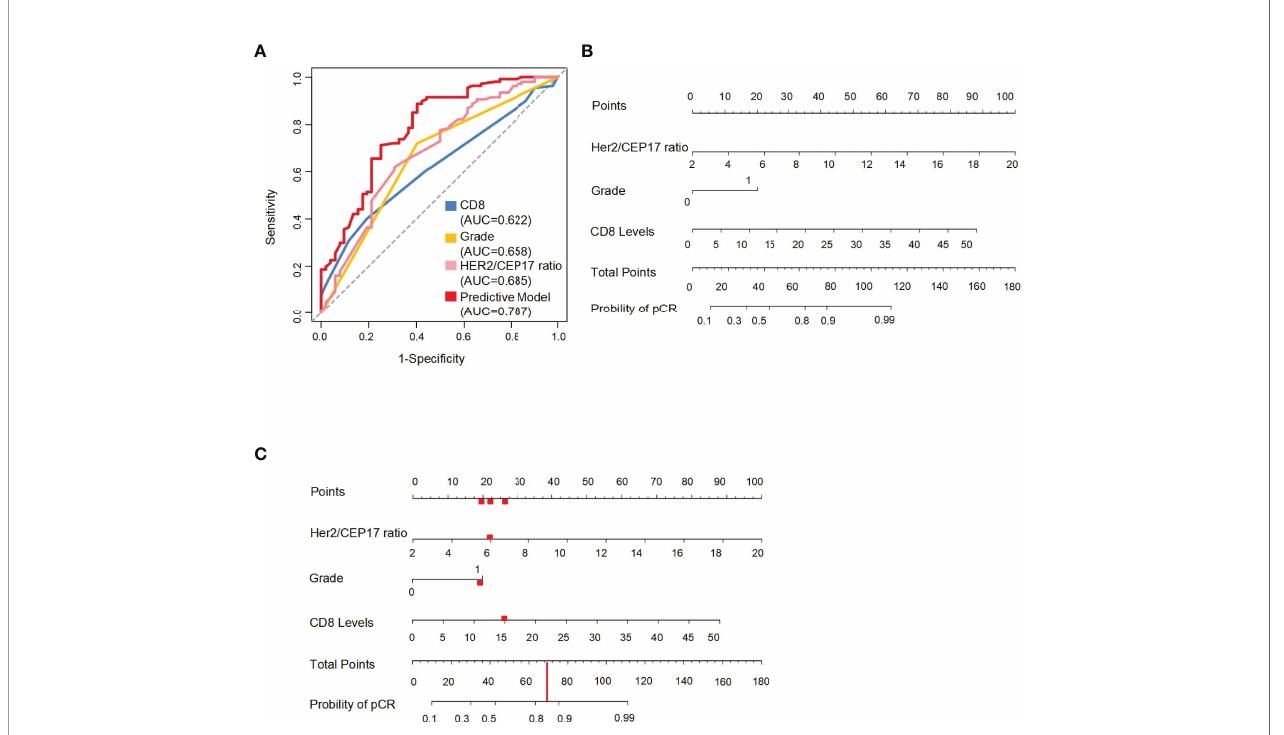
FIGURE 3 | The ROC curves of the HER2/CEP17 ratio, CD8 levels, and histological grade and the predictive nomogram model. (A) ROC curves constructed using the HER2/CEP17 ratio, CD8 levels, and histological grade in the whole cohort. (B) Nomogram to predict the probability of pathological complete response (pCR). HER2/CEP17 ratio, CD8 levels, and histological grade (0 present grade I – II, 1 present grade III) in the training set. (C) The red line and dots demonstrate usage of the model: a patient of HER2-ampli fi ed breast cancer with histological grade 3 and 15% of CD8 levels, and HER2/CEP17 ratio is 6 would have a total of 70 points (20 for histological grade 3, 22 for HER2/CEP17 ratio, and 28 for CD8 levels). The predictive value of pCR after NAC for this patient is